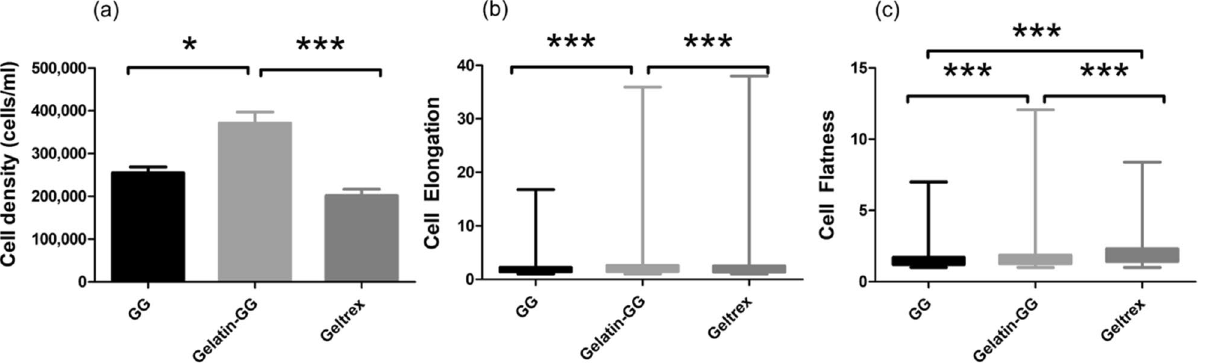
Figure 4. Quantative results of cell density and elongation for human lung fibroblasts cultured for 7 days in three different hydrogel formulations (GG, Gelatin-GG, and Geltrex) plotted using bar chart and a Box- Whiskers diagram; ( a ) cell density, ( b ) cell elongation, and ( c ) cell flatness. One-way ANOVA with Bonferroni multiple comparisons test was used to compare density of cells in different hydrogel formulations. Cell elongation and flatness were analyzed using non-parameterric Kruskal–Wallis rank test with Dunn’s pairwise comparison test. n = 3, (* P < 0.05; ** P < 0.01; *** P <